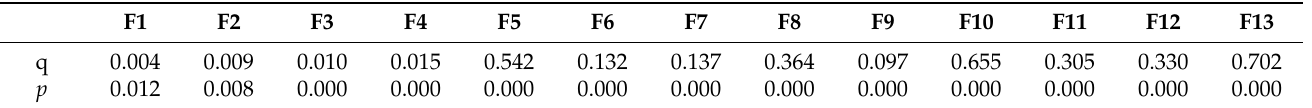
Table 6. Impact factor detection analysis table.